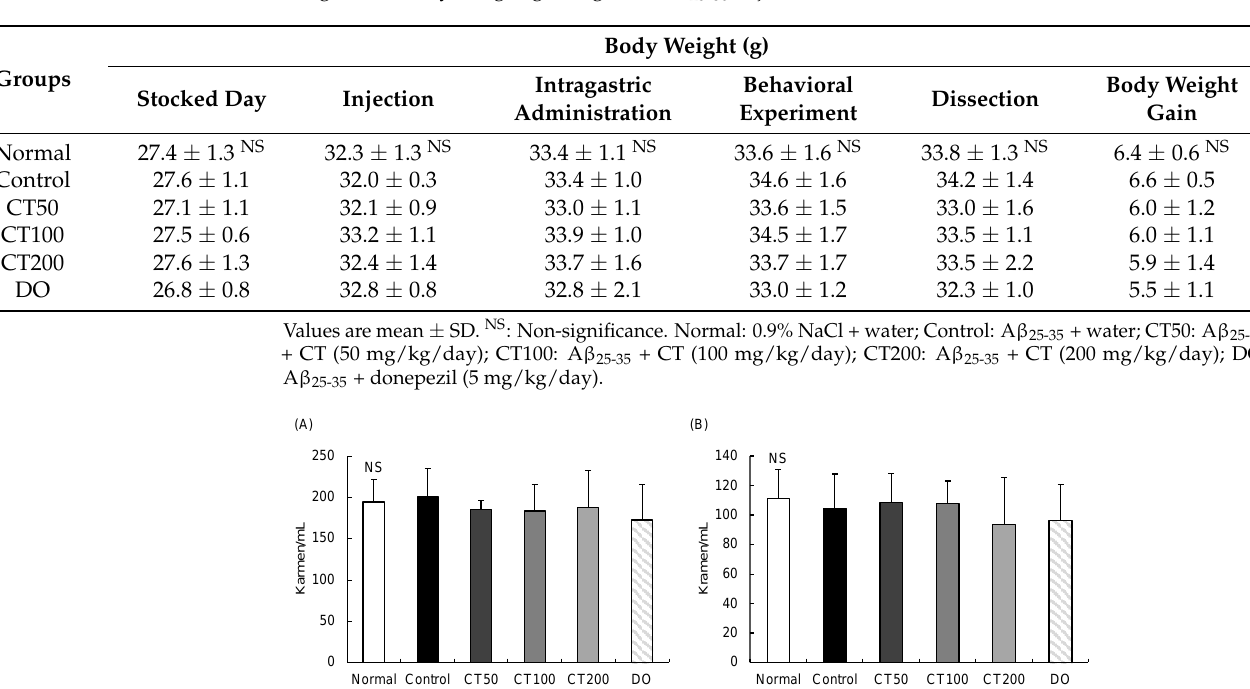
Table 1. Effect of combination with Carthamus tinctorius L. seed and Taraxacum coreanum (CT) on body weight and body weight gain against Aβ 25-35 -injected mouse.